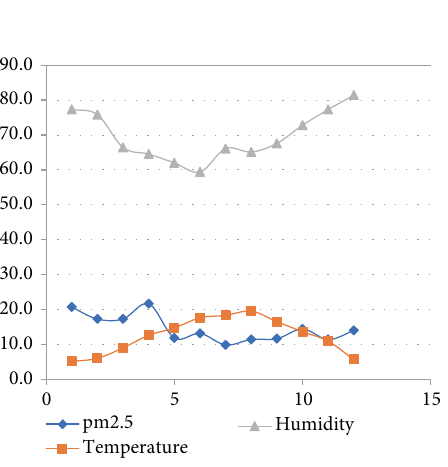
Figure 14: Curve relation among humidity, temperature, and PM2.5 during 2011 over